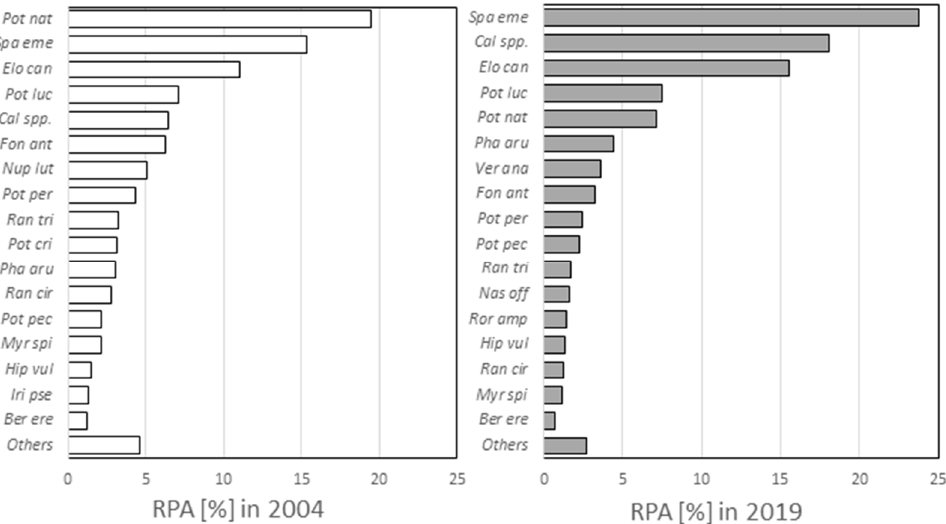
Figure 3. Comparison of the relative plant abundance (RPA) in different time periods. The value is expressed as a percentage and represents the biomass of each species in the watercourse.